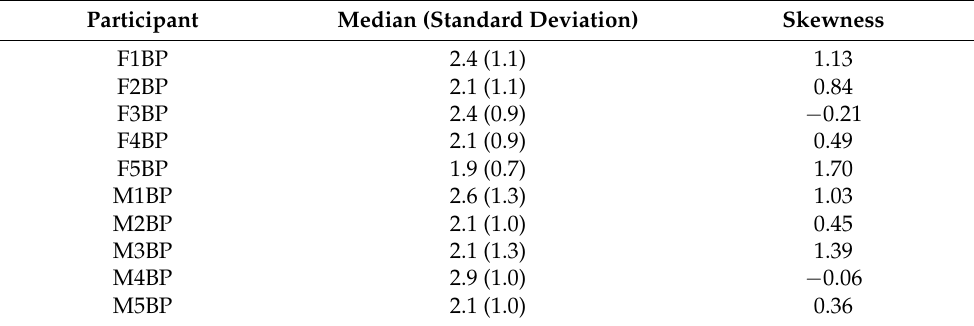
Table 2. Median (and standard deviation) in s, and Pearson skewness of IPI for the Brazilian participants of the Current